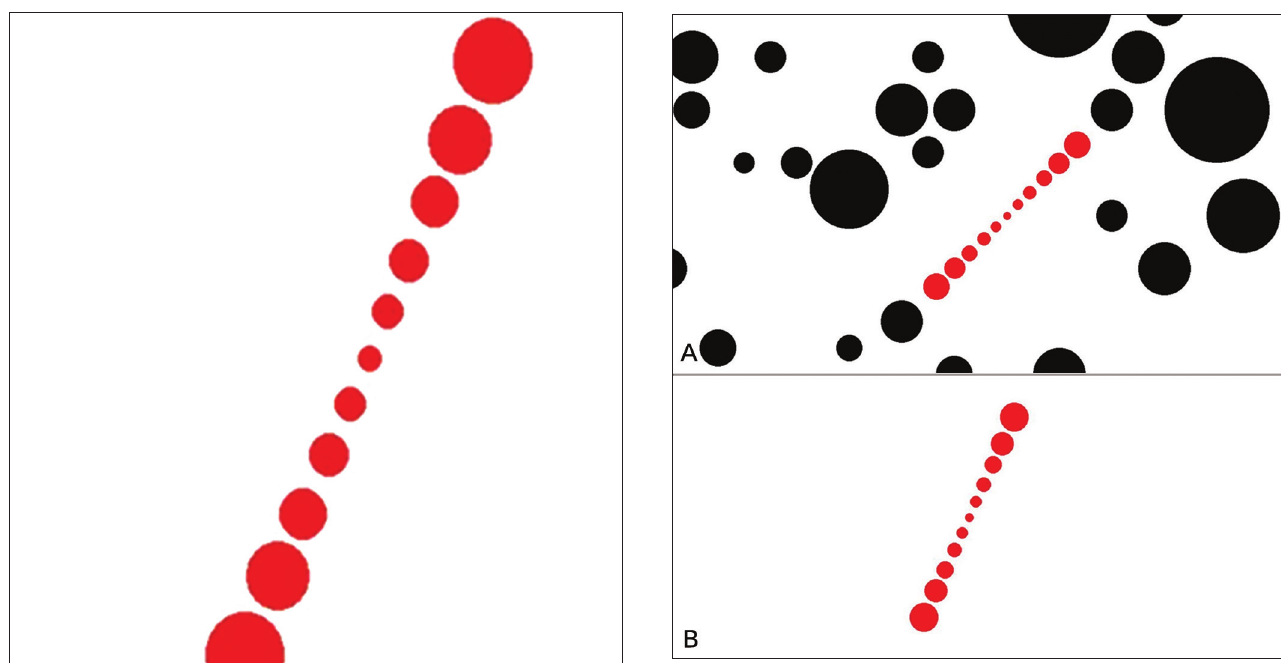
Figura 2. A: Representação de excitação visual em tela cheia. Para condição dinâmica. B: Representação de excitação visual em tela cheia. Para condição estática.